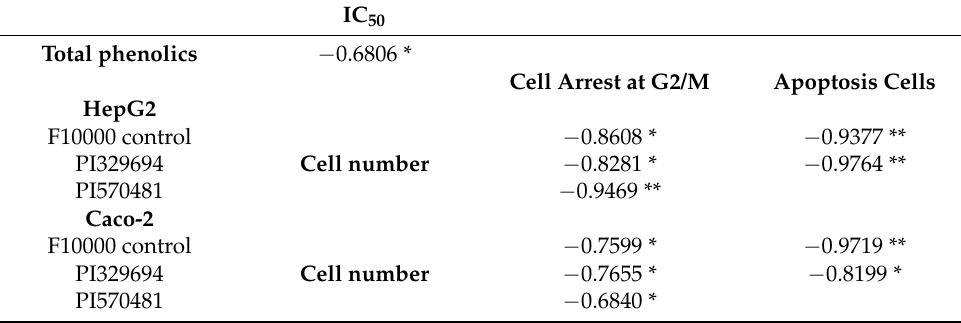
Table 3. Correlation coefficient (r) between phenolic contents and IC 50 values from the phenolic extracts of 13 sorghum accessions in HepG2 cells, or between cell number and cell cycle arrest or apoptosis from control, PI329694 and PI570481 in both cell